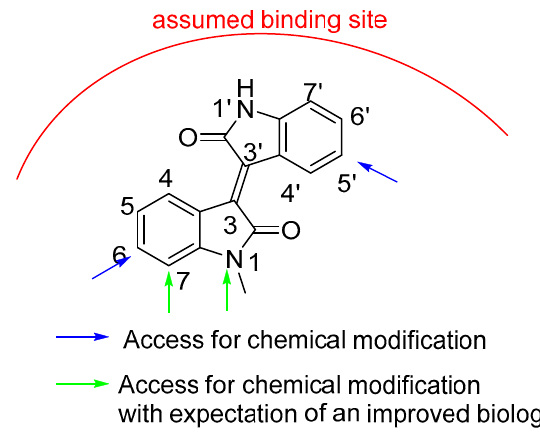
Figure 3. Assumed binding site and potential accesses for chemical modification of isoindigo.